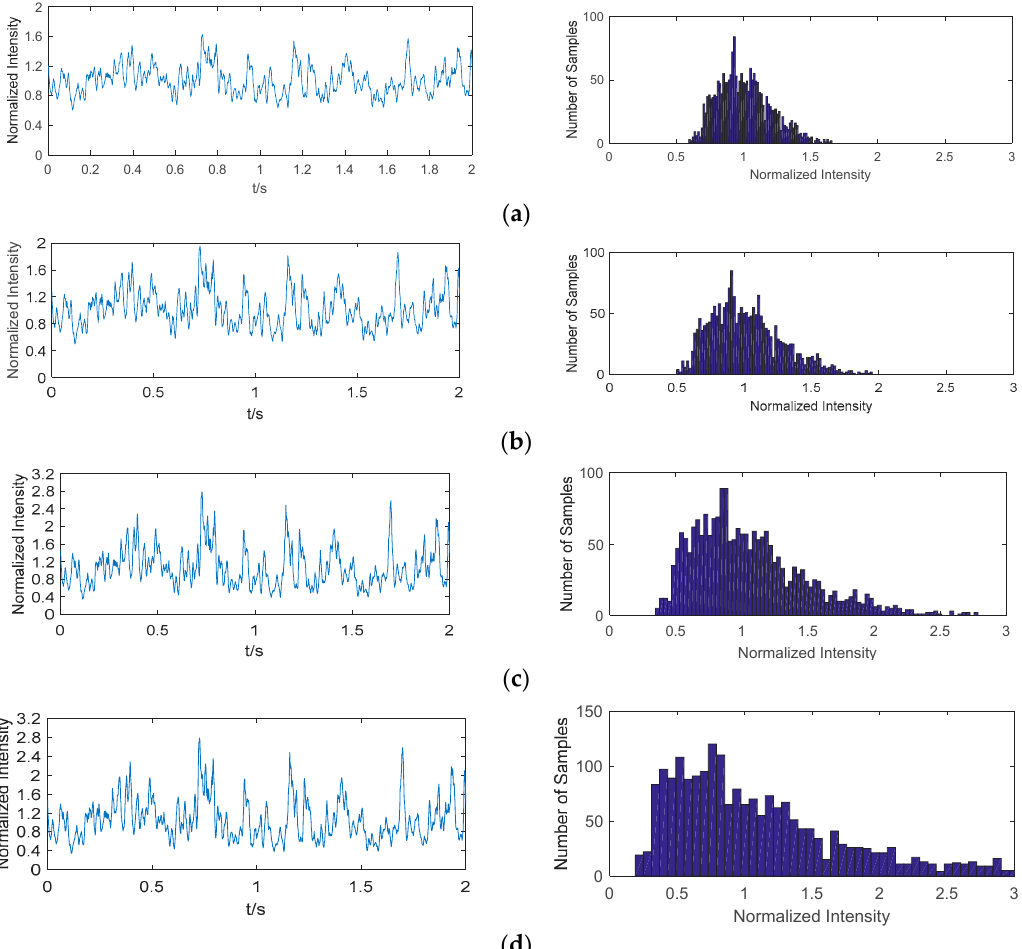
Figure 8. The curves and histograms of the channel gain with various aperture diameters. The diameters are: ( a ) 0.8 m; ( b ) 0.6 m; ( c ) 0.4 m; ( d ) 0.2 m.